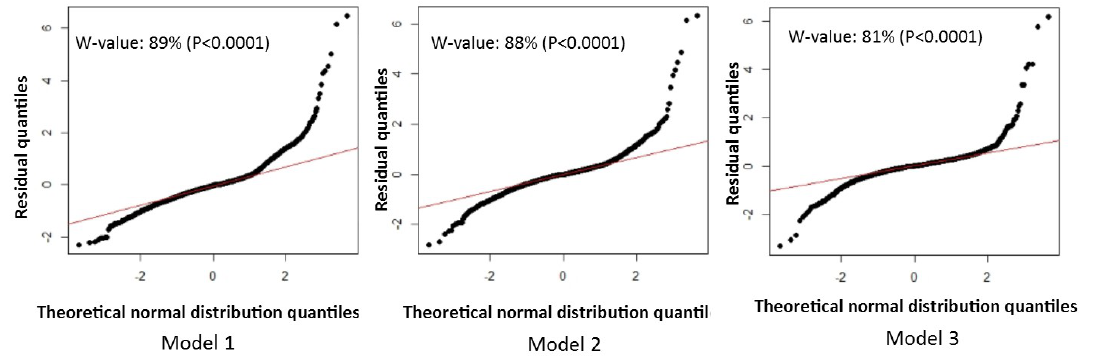
Figure A3. The Q-Q plots of residuals of all PV systems in Table 4. W-value: The percentage number from Shapiro-Wilk’s W test. P: p value reports the statistical significance of the